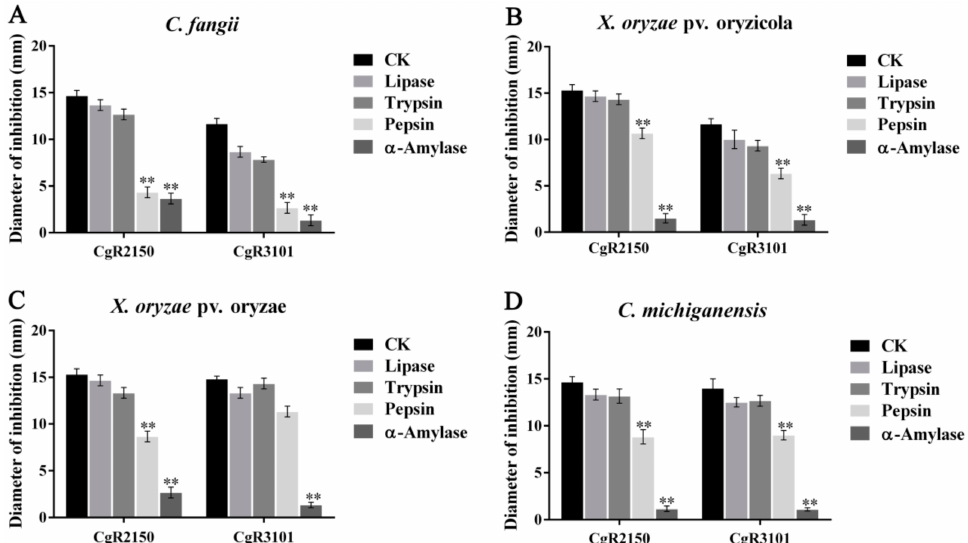
Figure 8. Enzyme stability assay of CgR2150 and CgR3101. Using the antimicrobial peptide without protease treatment as a control, the changes in the antimicrobial activity of the two peptides were observed through different biological enzyme treatments. ( A ) C. fangii , ( B ) X. oryzae pv. oryzicola, ( C ) X. oryzae pv. oryzae, and ( D ) C. michiganensis are the bacteriostatic diameter of two peptides treated with four different proteases, including lipase, trypsin, pepsin, and α -amylase. The data are the mean values obtained after three independent experiments, and the vertical bars are the standard deviations (SD). Significance analysis was performed by t -test; ** p <